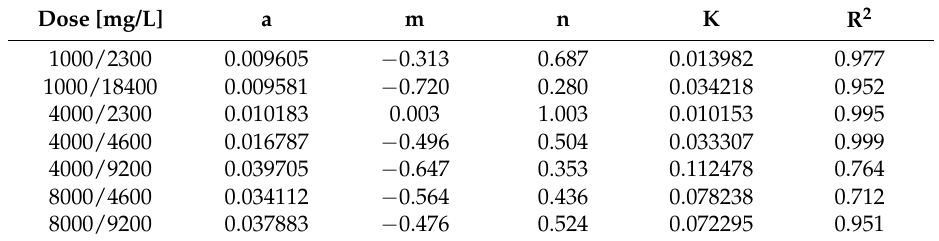
Table 5. Parameters of the empirical kinetic equation for Fe 0 /H 2 O 2 process after acidification at pH 3.0. Dose [mg/L]